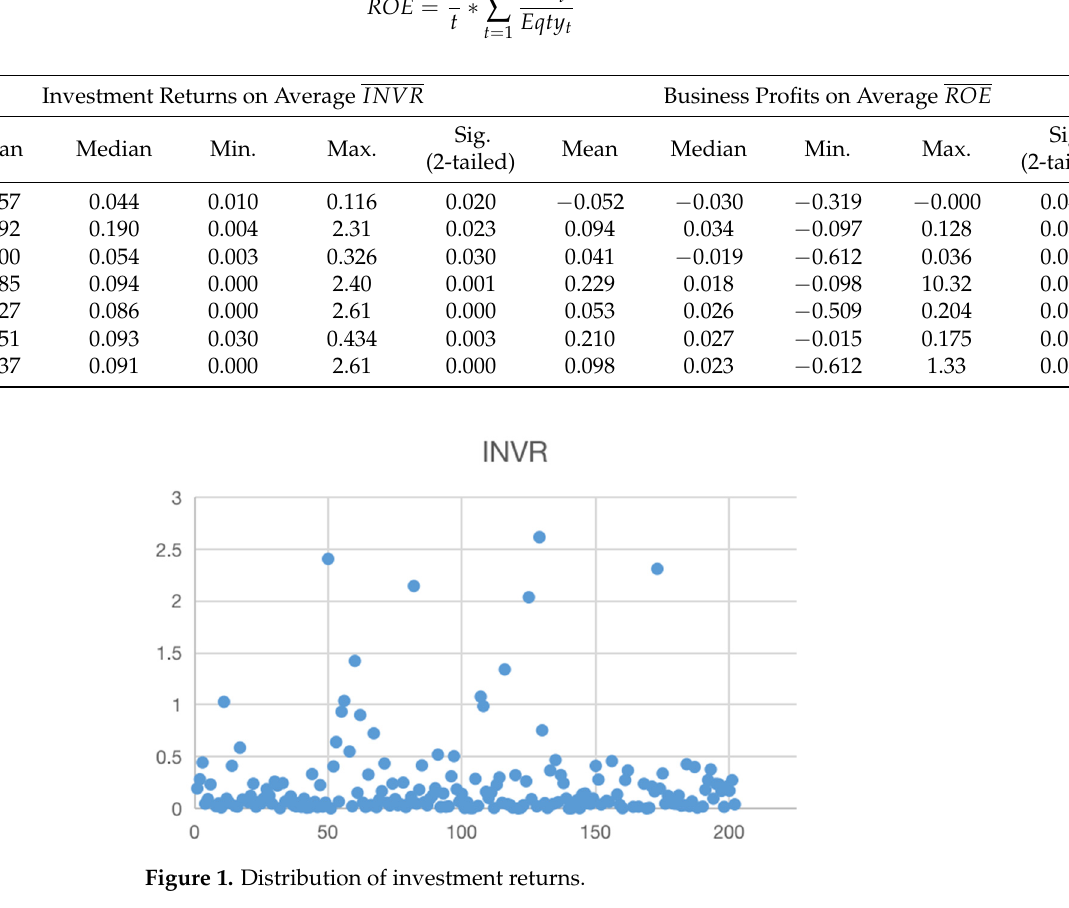
Table 6. Comparisons of investment returns and business profits on average.